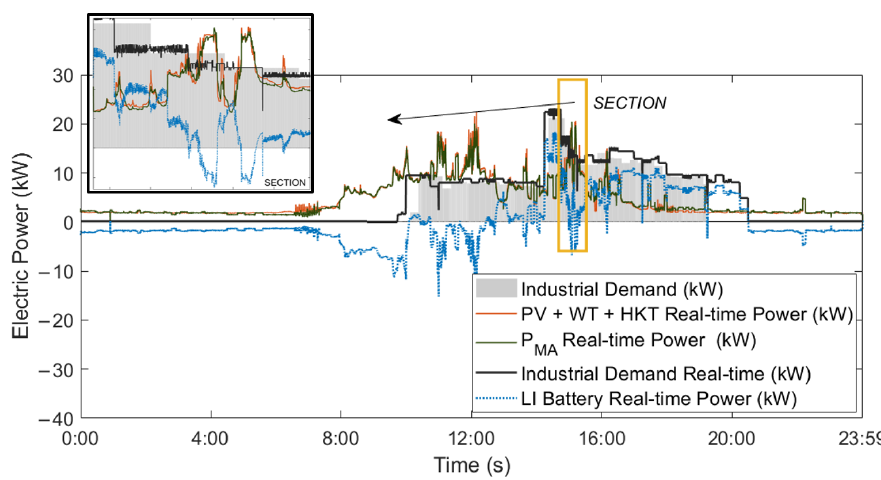
Figure 21. Comparison of the MA method between simulated data and laboratory tests.